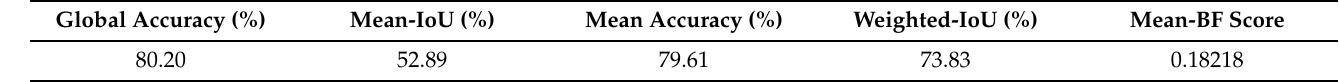
Table 3. Di-CNN Testing Results.